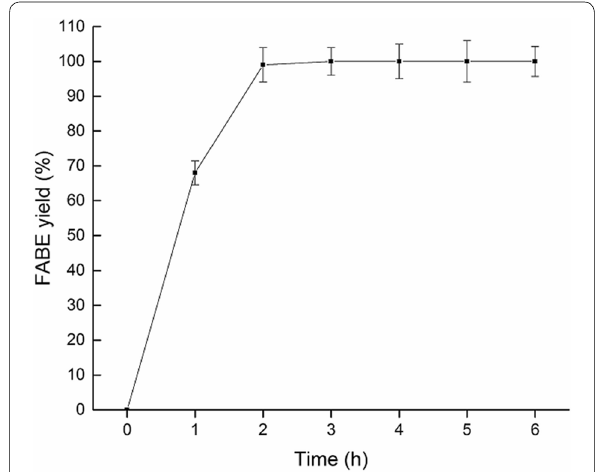
Fig. 10 FABE yield (%) obtained in the transesterification between castor oil and butanol, using 0.5 Zn/Mg